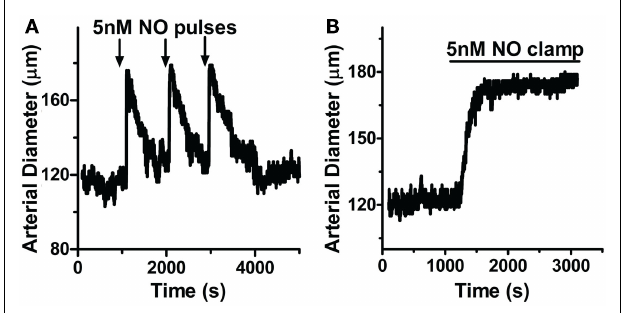
FIGURE 9 | Sensitivity of sGC to steady-state NO inVSM cells and pressurized mesenteric arteries. (A) Representative myograph trace of a cannulated mesenteric artery with myogenic tone exposed to step-wise increases of clamped NO (0.05–2 µ M). (B) NO dose-response curve derived from multiple NO exposed arteries ( n = 5). EC 50 s are calculated from individual myograph traces, then averaged (see